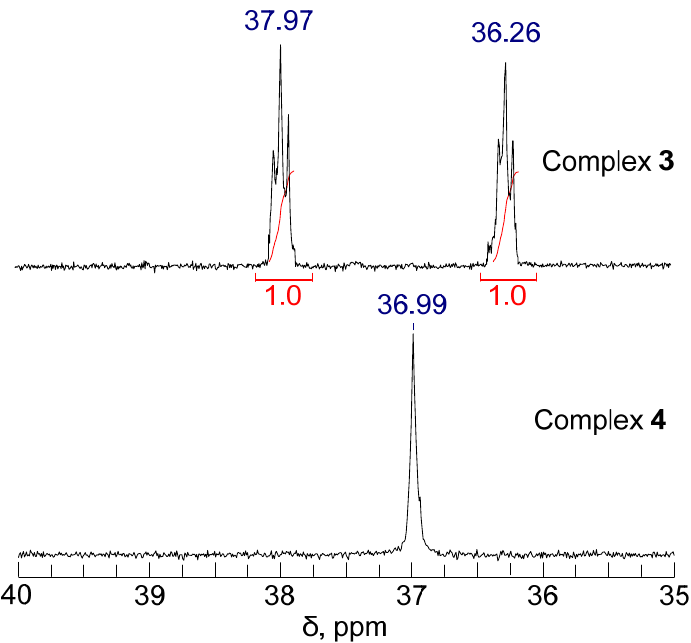
Figure 1. 31 P NMR spectra of complexes 3 and 4 in CD 2 Cl 2 .